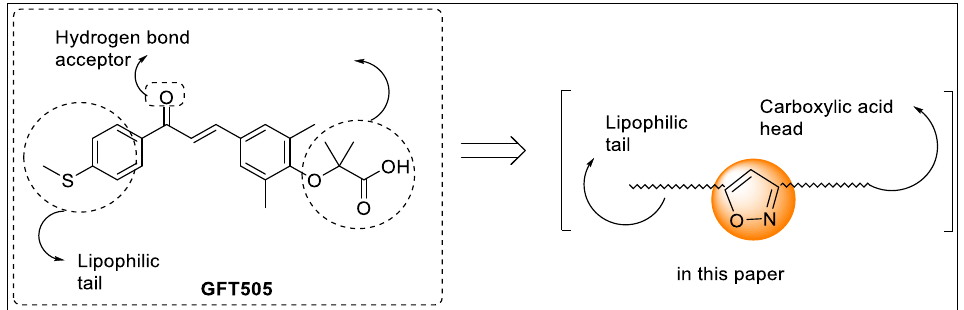
Figure 18. The rationale behind choosing oxazole hybrids as potent PPAR ligands.